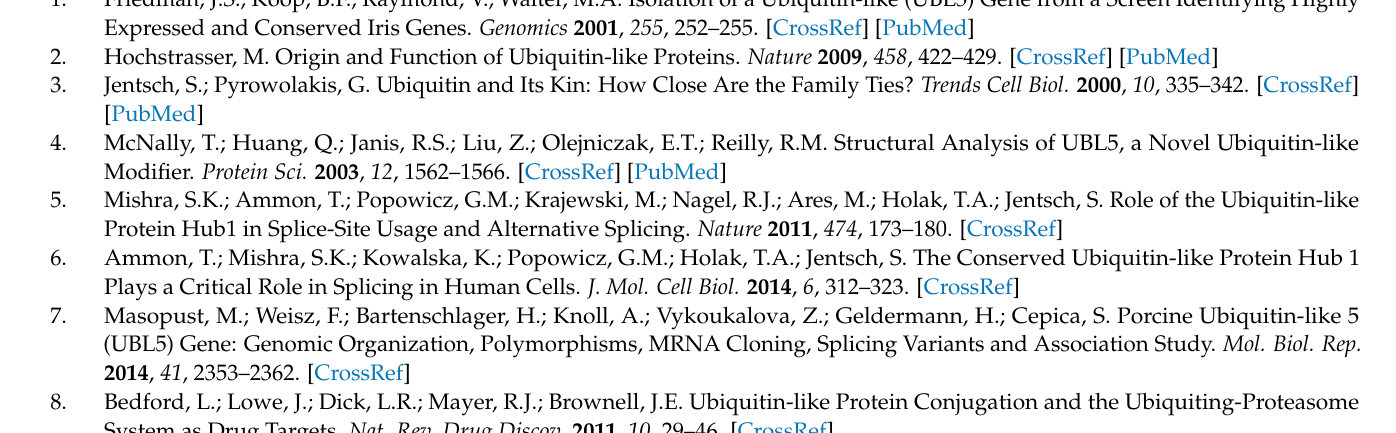
peptide-14; Table S1: Summary table of interface analysis of PDBePISA; Table S2: Input commands for the docking associated to the peptide from Snu66 (HINDI domain); Table S3: Summary table of the CABS-dock modeling stage; Table S4: Summary table of the CAPRI assessments across all of the modeling stages; Table S5: Summary table of the Fnat values calculated across all of the modeling stages; Table S6: Summary table of the LRMS values; Table S7: Summary RMSD (Å) table of the top 10 medoid in the all-atom representation; Table S8: Structures and code names of the tested fragments. Plate 1; Table S9: Structures and code names of the tested fragments. Plate 2; Table S10: Structures and code names of the tested fragments. Plate 3; Table S11: Structures and code names of the tested fragments. Plate 4; Table S12: Structures and code names of the tested fragments. Plate 5; Table S13: Structures and titration 1 H and SOFAS HMQC experiments of the initial